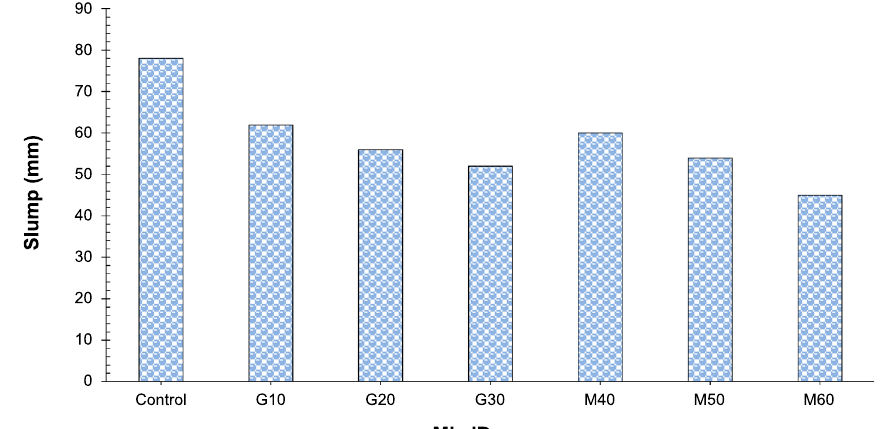
Figure 3. Slump test results.